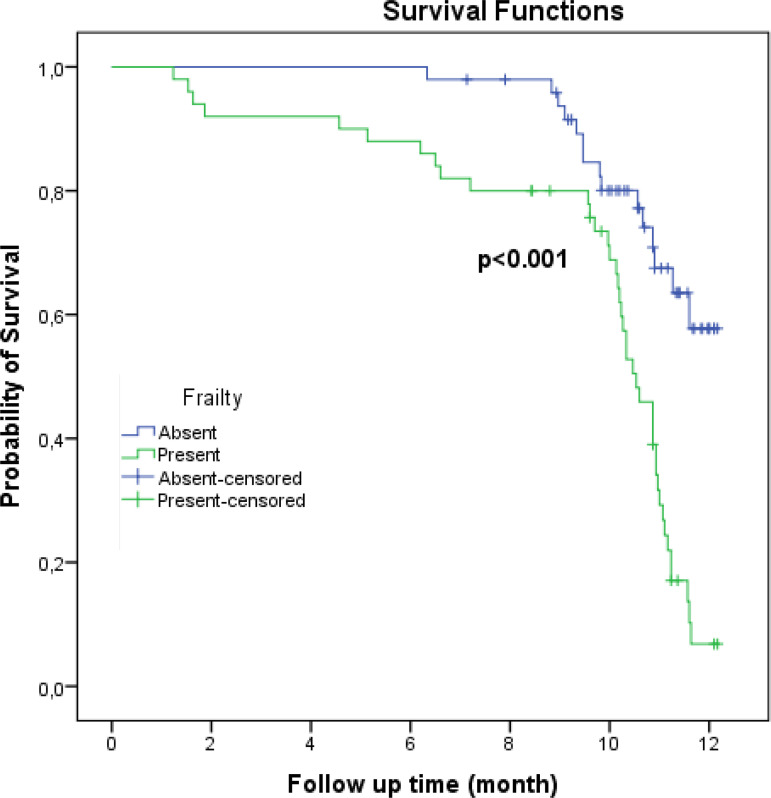
Kaplan-Meier curves of freedom from Major Adverse Cardiac Events (MACE) to one year. MACE probabilities and their 95% confidence ıntervals in the time “12 months” are 0.58 (0.40-0.76) for non-frail patients and 0.07 (0.00-0.15) for frail patients.